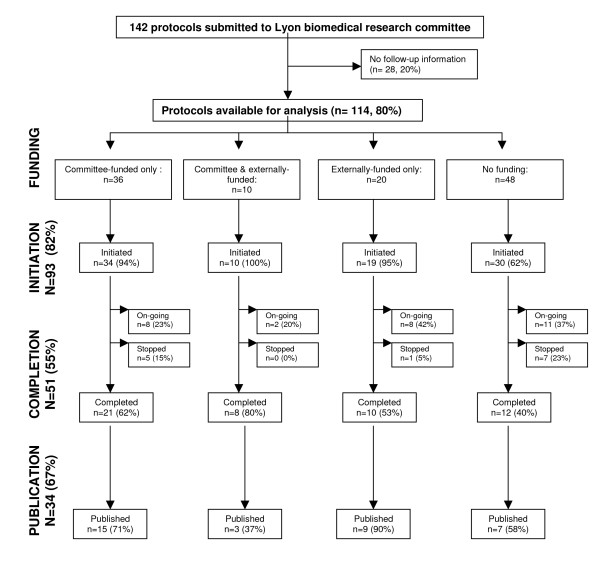
Fate of protocols submitted to a regional scientific committee.